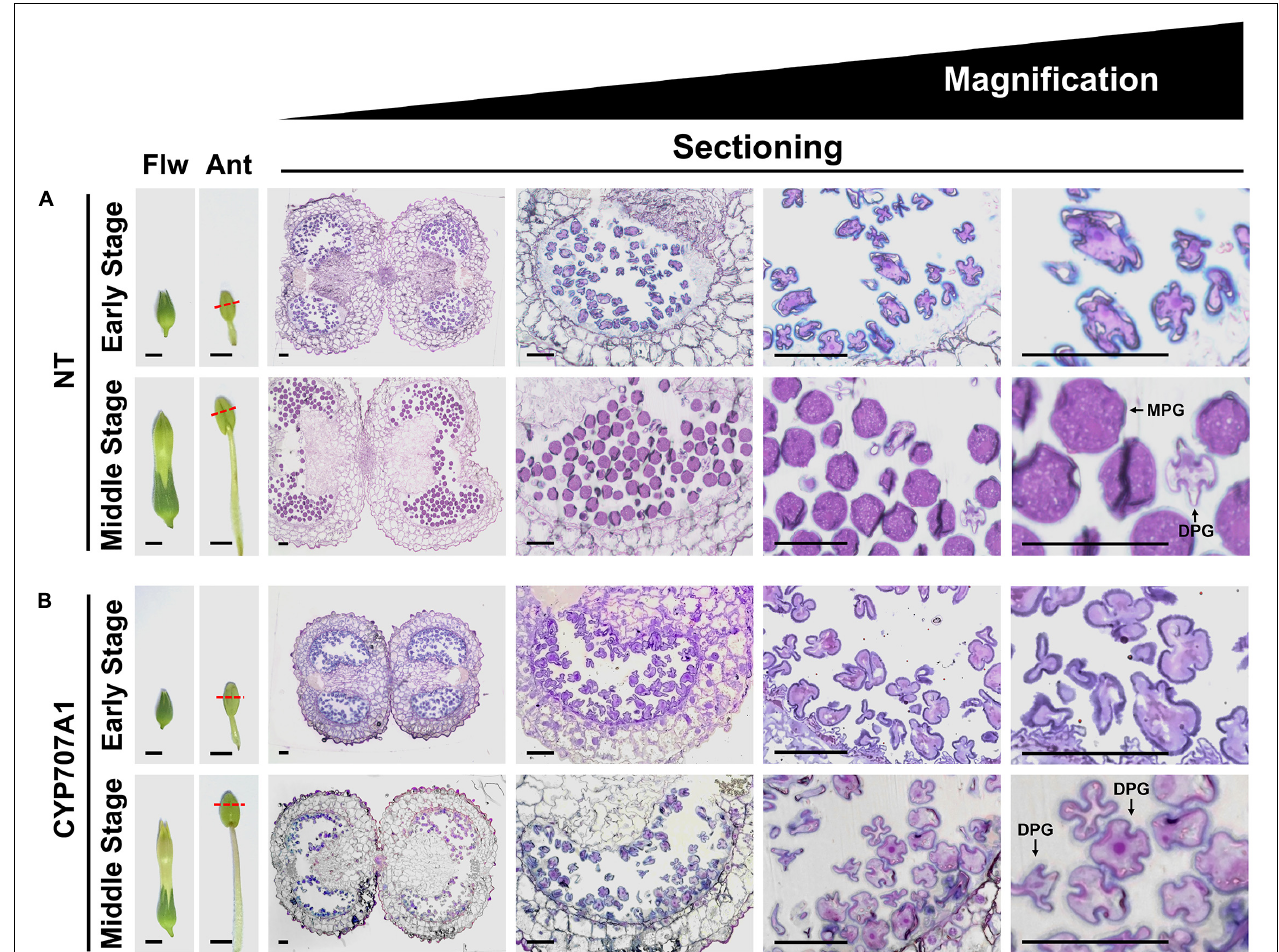
FIGURE 5 | Overexpression of CaCYP707A1 affects pollen maturation. (Left) Images of flowers (Flw) and anthers (Ant), and (right) semi-thin section images showing pollen development in early stage and middle-stage flowers of NT (A) and 35S:CaCYP707A1 #1 (CYP707A1) plants (B) grown in the same conditions. The slices were stained with toluidine blue O, and the images were captured by light microscope. Red dashed lines marked the longitudinal positions from which the slices were obtained. Ant, anther; DPG, degenerated pollen grain; Flw, flower; MPG, mature pollen grain. Scale bars = 0.5 cm in flowers, 0.2 cm in anthers, and 50 µ m in sectioning images. More than three individuals of the indicated plants were analyzed, and the experiments were performed two times with similar